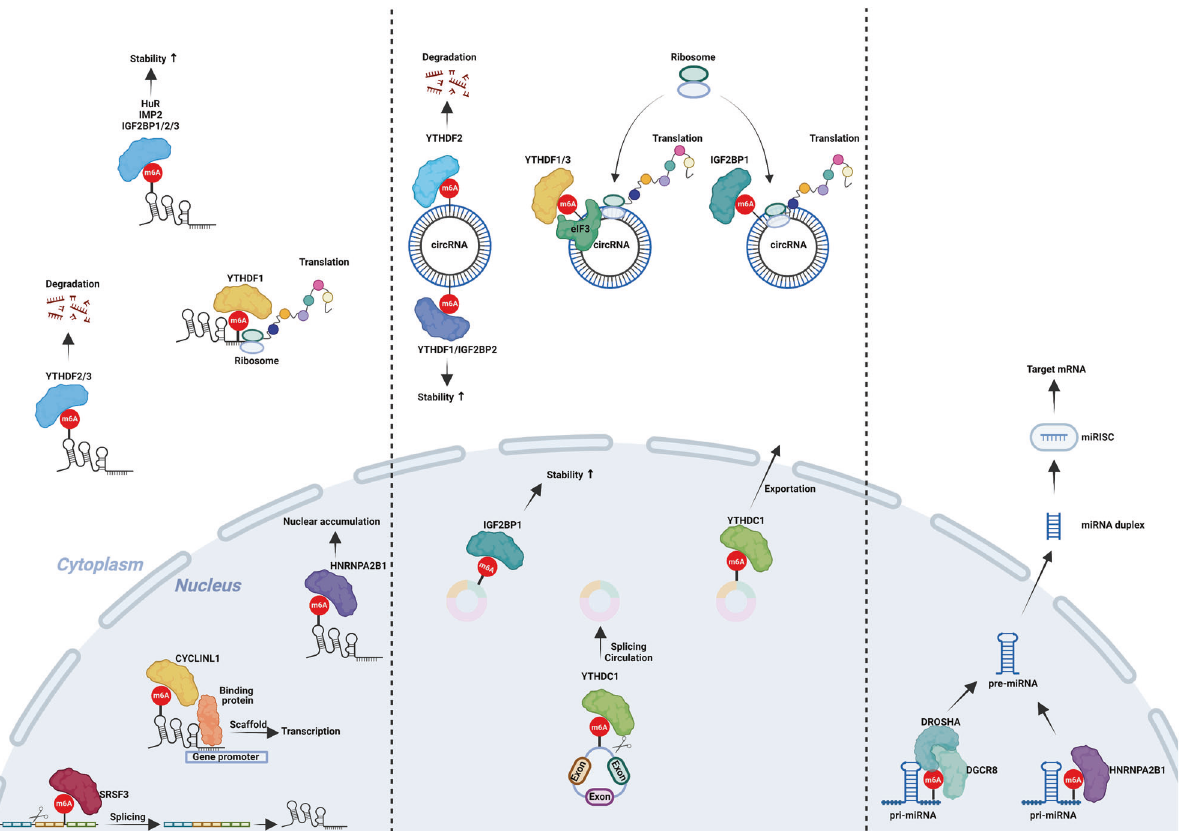
Fig. 4 Functions of m6A modi fi cations in noncoding RNAs. The functions of m6A modi fi cations in circRNAs (left) include reverse shearing, changes in stability, and enhanced cytoplasmic transport; these circRNAs are also able to be translated. The functions of m6A modi fi cation in lncRNAs (middle) include splicing, acting as molecular scaffolds, nuclear accumulation, and stability changes, and these lncRNAs can also be translated. The functions of m6A modi fi cations (right) are mainly to promote their